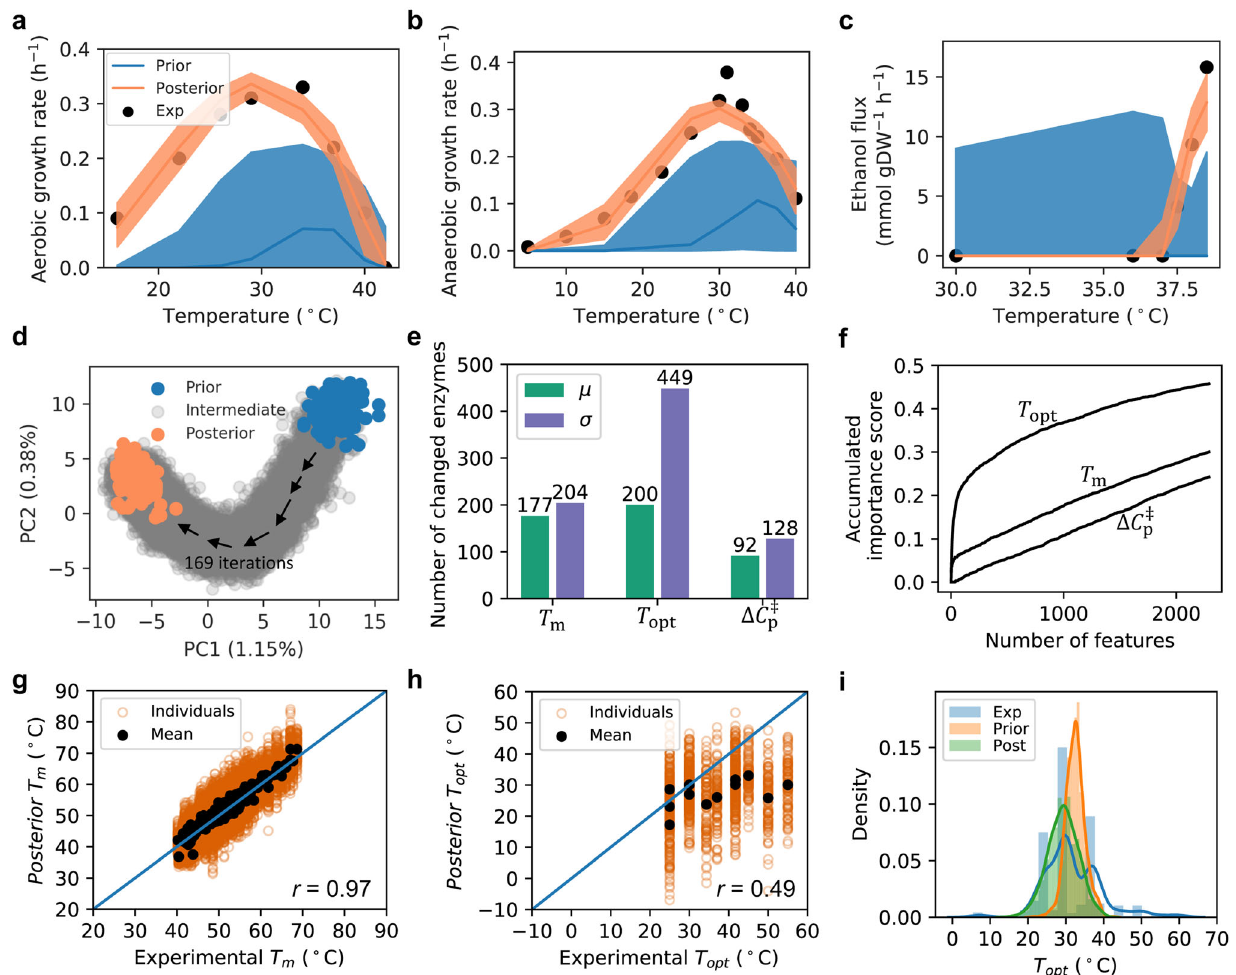
Fig. 2 Bayesian modeling improves etcGEM performance by reducing parameter statistical uncertainties. a , b Simulated ( a ) aerobic and ( b ) anaerobic growth rates in batch cultivations at various temperatures with Prior and Posterior etcGEMs. c Simulated ethanol secretion fl ux in a chemostat at various temperatures. In a – c , lines indicate median values and shaded areas indicate regions between the 5th and 95th percentiles ( n = 128 for Prior and n = 100 for Posterior models). d Principal component analysis (PCA) 21,504 parameter sets ( ^ θ ) sampled in the Bayesian approach. Each parameter in the set θ * was standardized by subtracting the mean and then be divided by the standard deviation before PCA. ^ θ of 128 Prior and 100 Posterior etcGEMs are highlighted in blue and orange, respectively. All other ^ θ were termed as “ intermediate ” and marked in gray. e The number of enzymes, out of all 764, with a signi fi cantly changed mean ( Š idák adj. Welch ’ s t test p value < 0.01, two-sided) and variance ( Š idák adj. one-tailed F -test p value < 0.01) in T m , T opt , and Δ C z Prior and Posterior . Parameters from 128 Prior and 100 Posterior etcGEMs were used for statistical tests. f A random forest model was used to score the importance of all 2292 parameters during the Bayesian approach ( “ Methods ” ). The plot shows the accumulated importance score for each of the three- parameter categories. g Parity plot comparing the experimental T m values and ones in the 100 Posterior models. h Parity plot comparing the experimental T opt values from BRENDA and ones in the 100 Posterior models. In g , h , r denotes the Pearson ’ s correlation coef fi cient between experimental values and Posterior mean values. i Comparison among distributions of the mean of Prior T opt s, mean of Posterior T opt s (Post) and experimental T opt s (Exp) from BRENDA. The bimodal distribution of T opt values is due to the common values in BRENDA occurring at room temperature 25 °C (111 times), the optimal growth temperature of yeast 30 °C (244 times), and 37 °C (142 times). Source data are provided as a Source Data fi